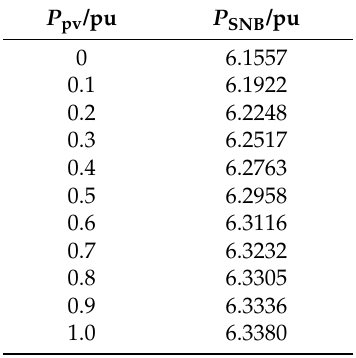
Table 3. The values of the load’s active power at the SNB points of IEEE 14-bus system with PV. P pv /pu P SNB